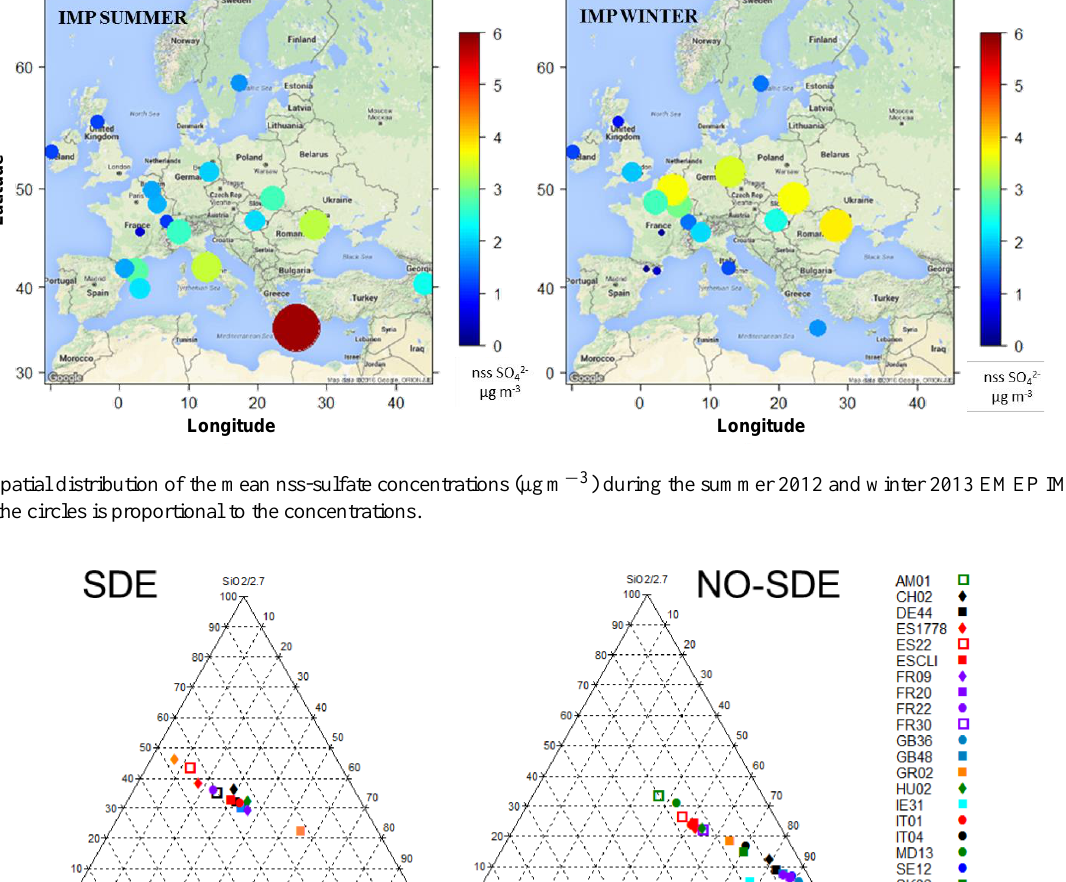
for days with (left, SDE) and without impact of 4